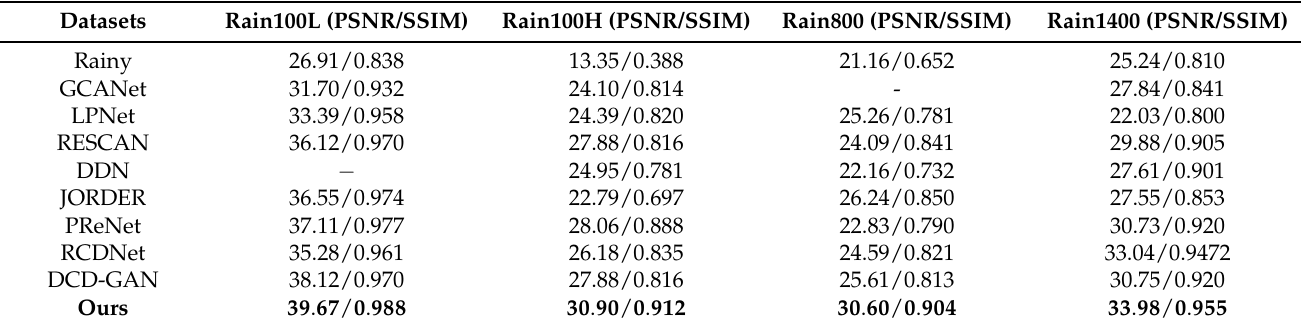
Table 2. The Comparison Results On Synthetic